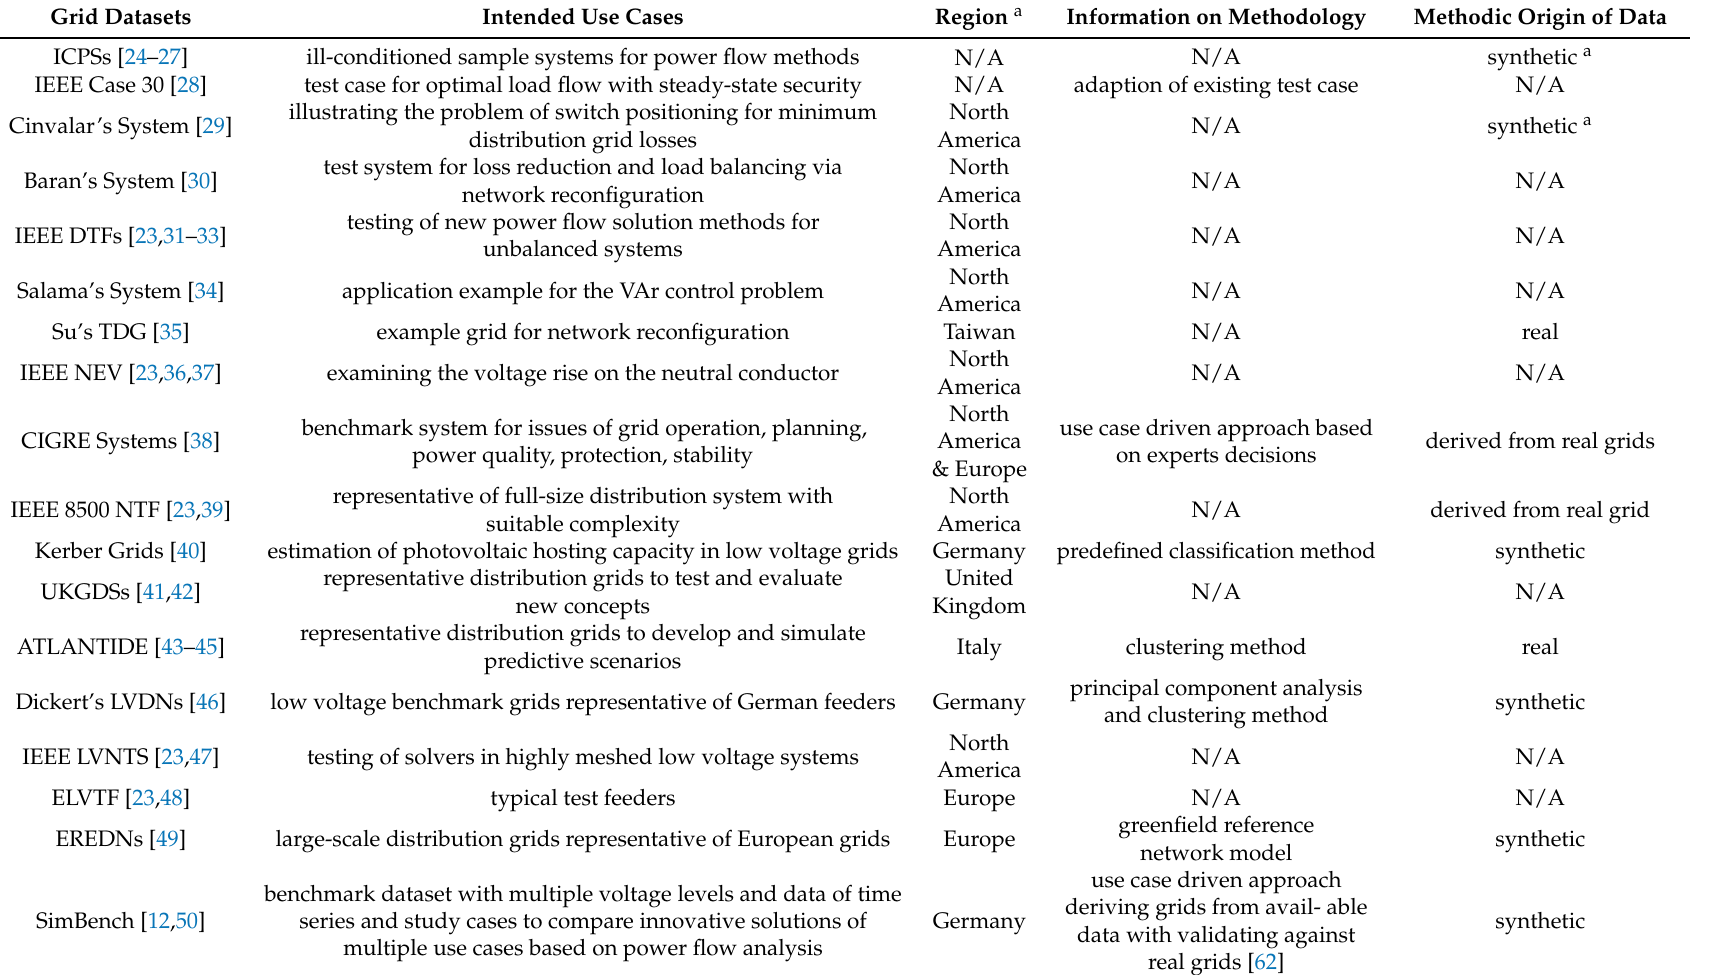
Table 2. Overview of intentions, generation methodologies and origins of publicly available